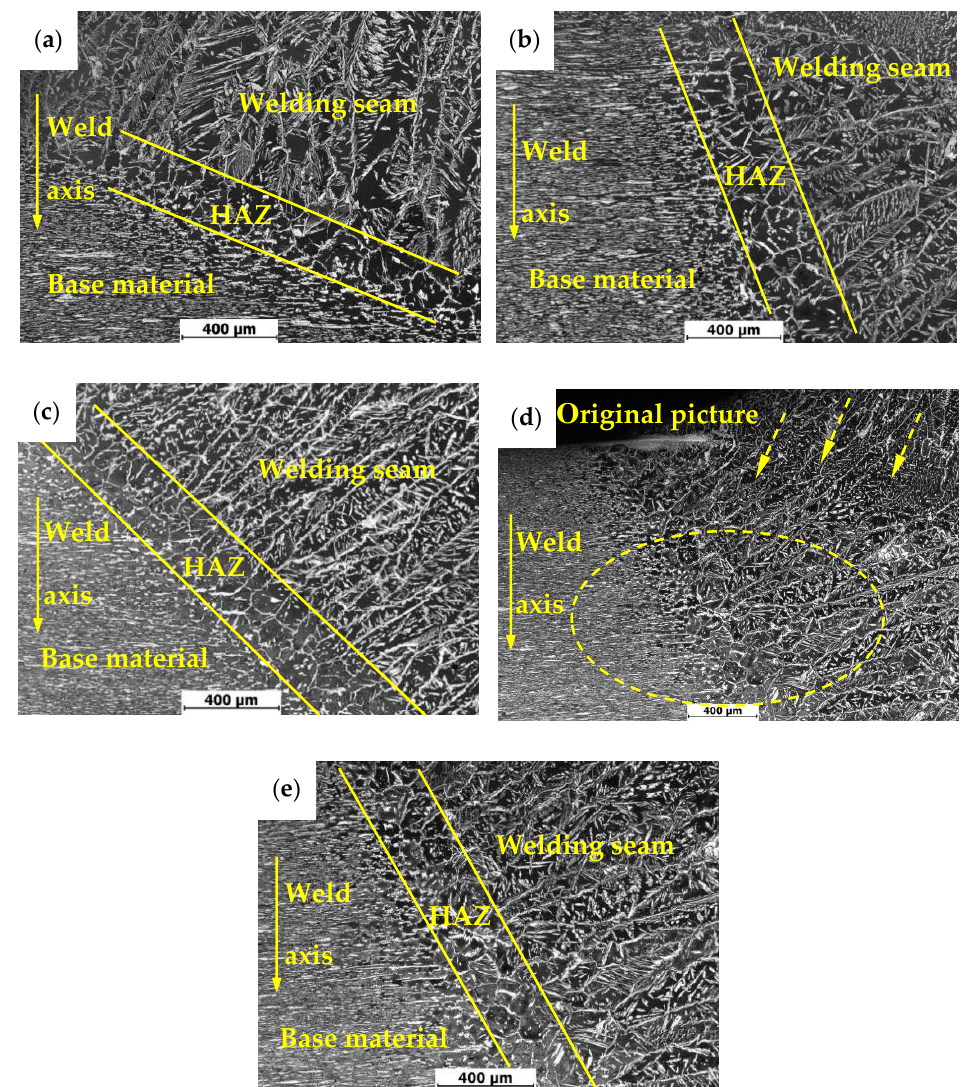
Figure 6. Metallographic structure of DSS 2205 heat-affected zone with different treatment methods: ( a ) untreated; ( b ) pneumatic chipping hammer; ( c ) ultrasonic peening treatment; ( d , e ) heat treatment.